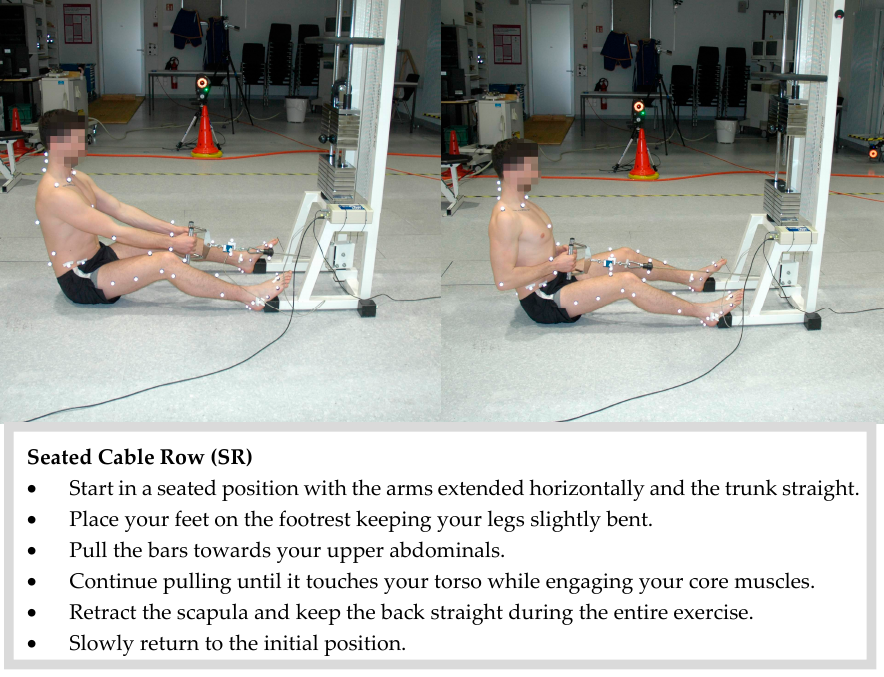
Figure A3. Experimental setup and execution of the seated cable row. The subject with a complete IfB marker set is shown.